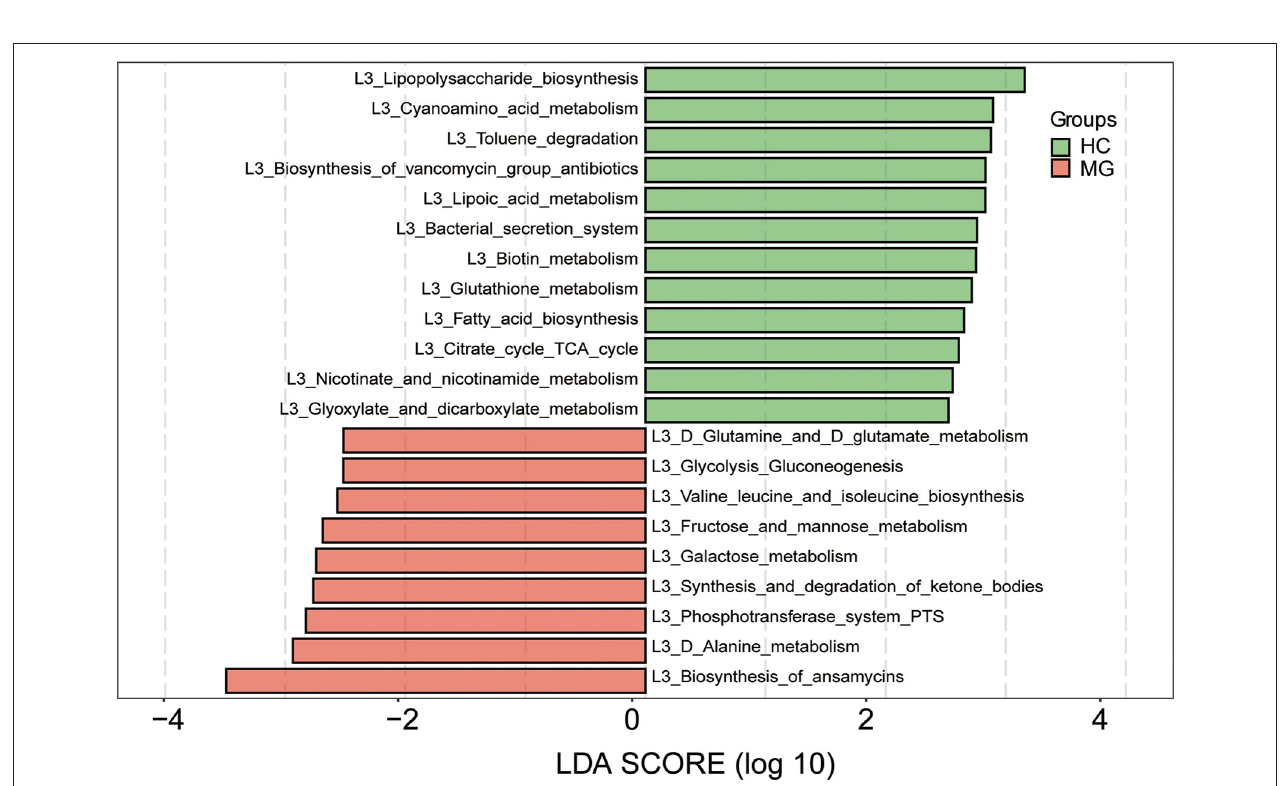
FIGURE 4 | Heatmaps of the relative abundance of differential OTUs between MG (N = 20) and HC ( N = 20) groups. For each sample, the columns show relative abundance data for differential OTUs on the right. The relative abundance of each OTU was used to generate the heatmap (blue, low abundance; red, high abundance). Group data are shown above the plot: MG, left, right line; HC, right, blue line. Each row represents one OTU.